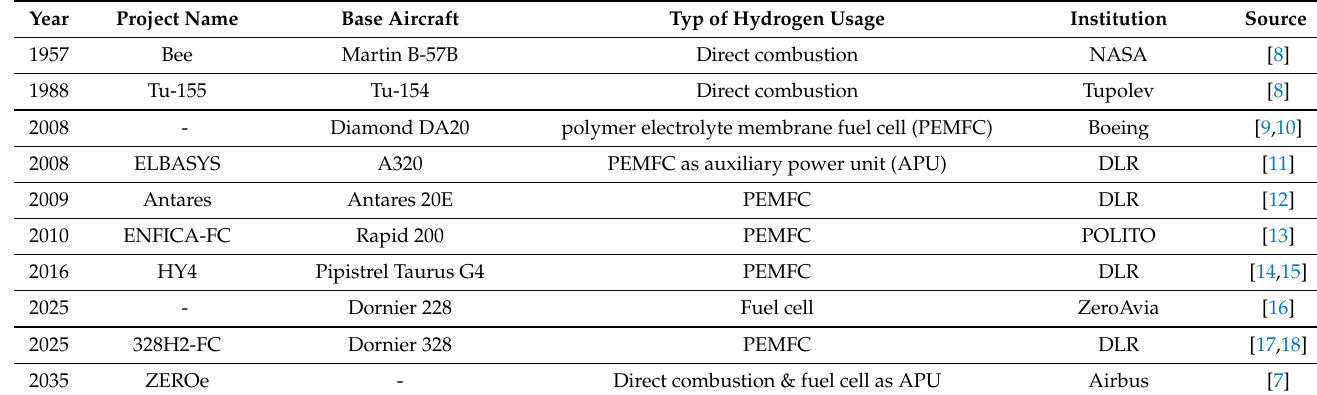
Table 1. Excerpt from relevant projects on hydrogen-powered